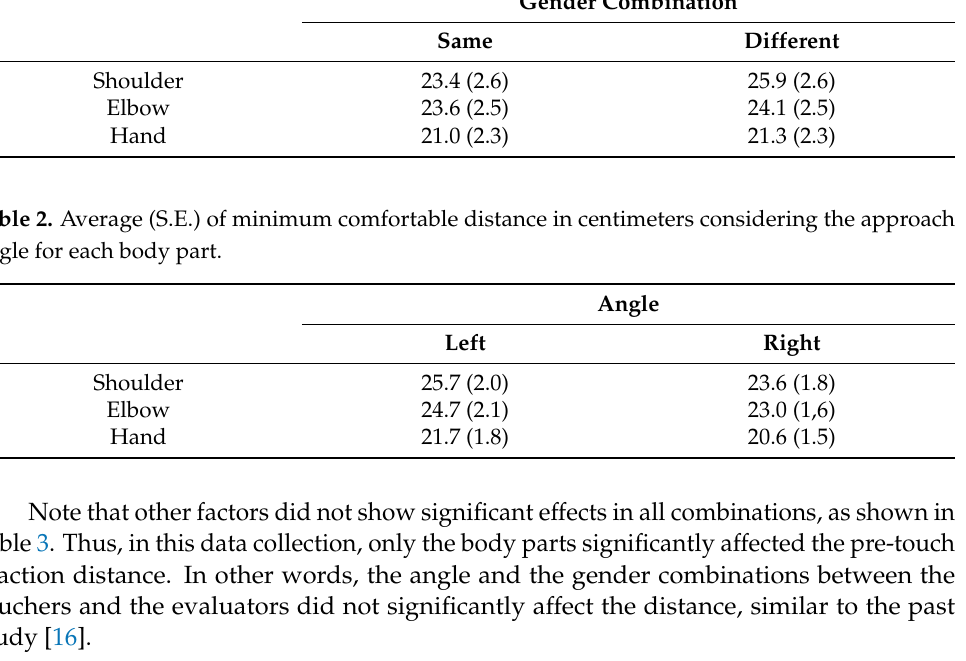
Table 3. Three-factor ANOVA results ( p < 0.05 in bold). Factor p